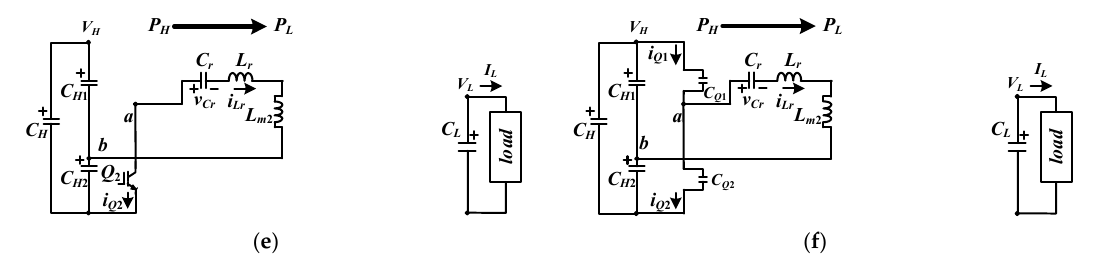
Figure 4. Equivalent topological circuits for each mode operation under forward power transfer ( a ) mode 1 ( b ) mode 2 ( c ) mode 3 ( d ) mode 4 ( e ) mode 5 ( f ) mode 6.